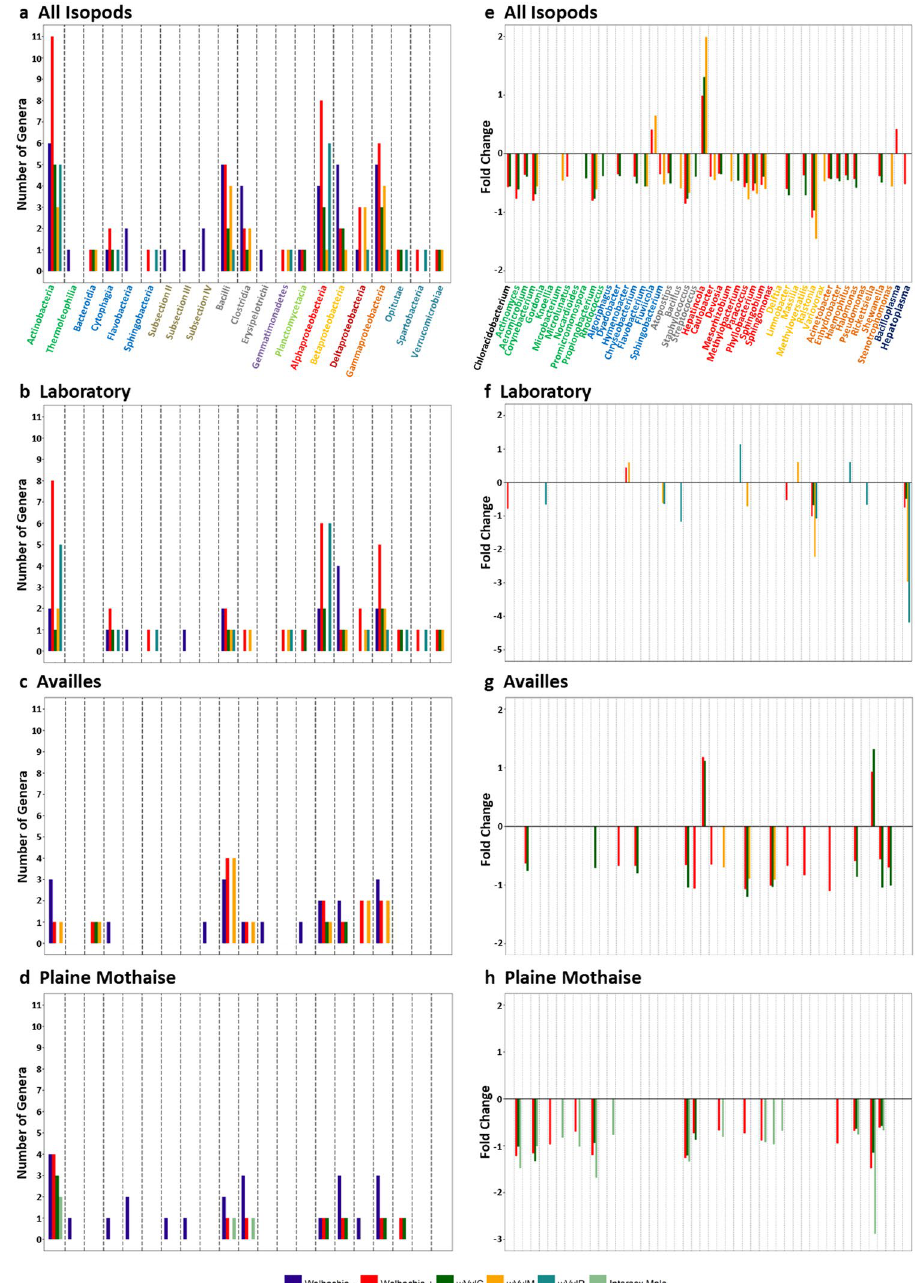
Figure 4. Differentially abundant bacterial taxa. ( a – d ) Histograms showing the distribution of genera per bacterial class which were specifically present or absent depending on Wolbachia infection, for all isopods independent of host origin ( a ) as well as for each population separately ( b – d ). ( e – h ) show the fold changes of the 48 genera identified as differentially abundant depending on Wolbachia infection using DESeq. 2, for all isopods independent of host origin ( e ) as well as for each population separately ( f – h ). The taxonomic identifications shown in ( a ) and ( e ) apply to all other panels and are colour-coded depending on bacterial phylum (or class for Proteobacteria): Acidobacteria = black, Actinobacteria = dark green, Bacteroidetes = light blue, Cyanobacteria = brown, Firmicutes = grey, Gemmatimonadetes = purple, Planctomycetes = light green, Alphaproteobacteria = red, Betaproteobacteria = light orange, Deltaproteobacteria = dark red, Gammaproteobacteria = dark orange, Tenericutes = dark blue, Verrucomicrobia =